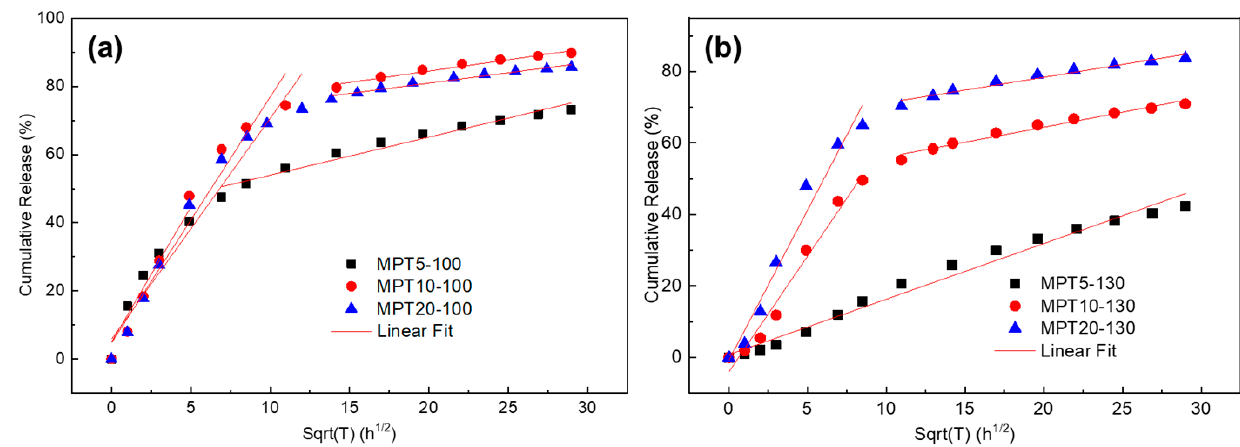
Figure 9. The release kinetics of PCL/MPT-100 ( a ) and PCL/MPT-130 ( b ) blends.